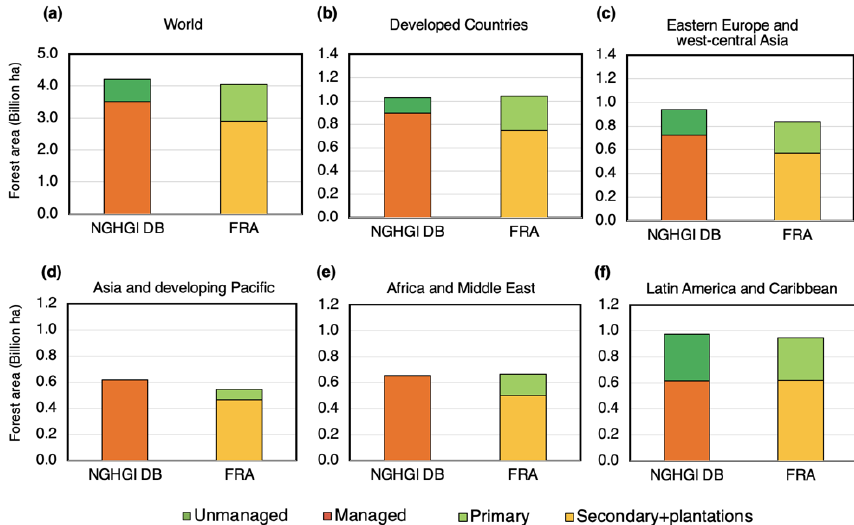
Figure 1. Global forest area reported to UNFCCC (as consolidated and gap filled in the NGHGI DB) (managed and unmanaged) and FRA (primary and secondary + plantations) for the year 2015 at global level (a) and for five macro regions (b–f) . For the NGHGI DB, about 1% of total forest area in NAI countries is gap filled with FAO data (i.e. 2, 43, and 1Mha in panels d , e , and f ,